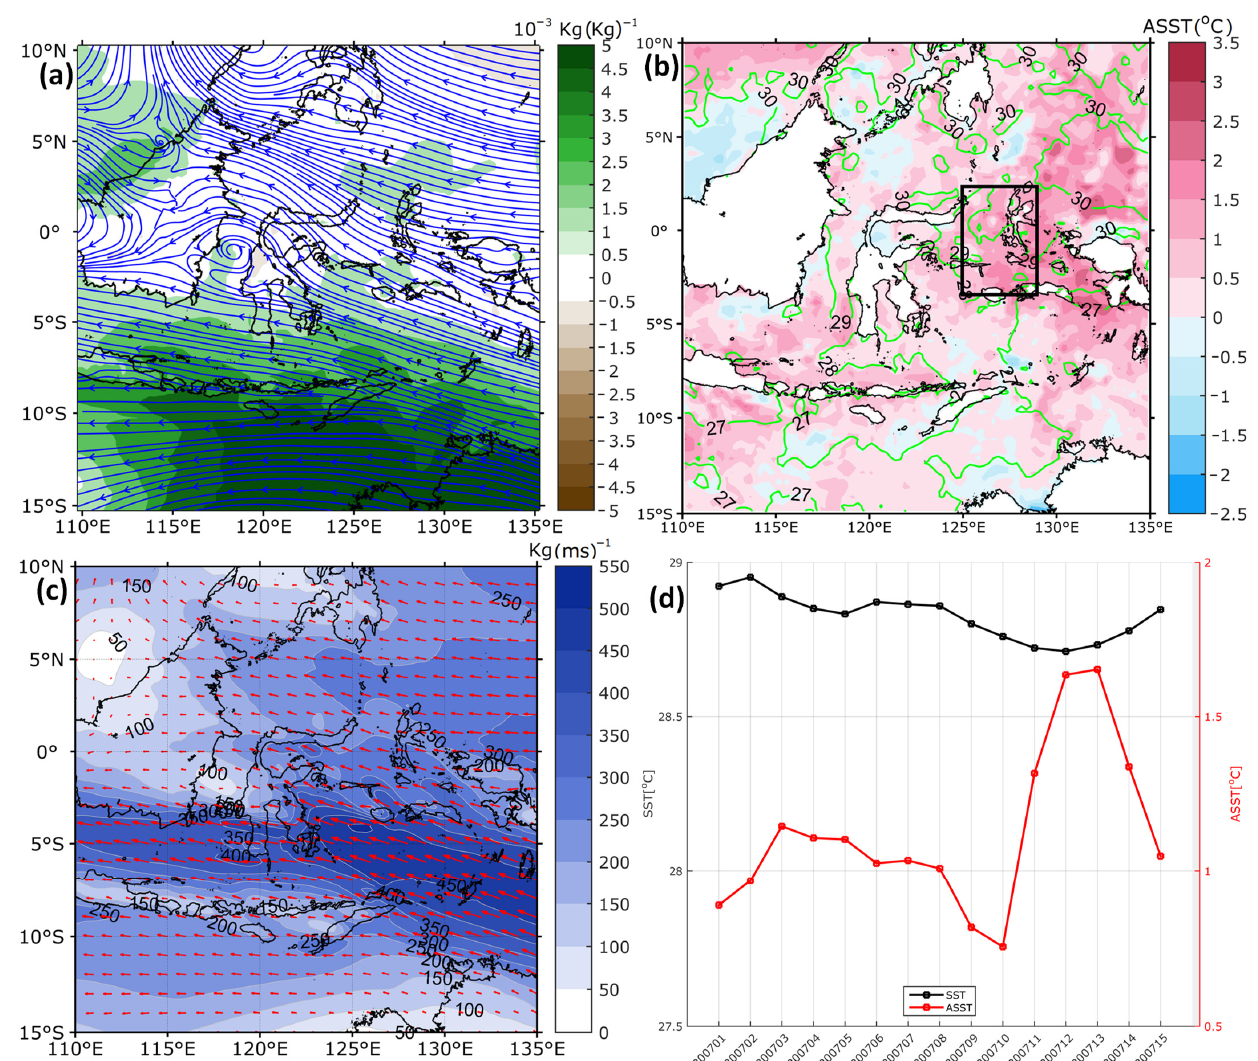
Figure 3. ( a ) Spatial map of specific humidity (shading) and wind at 850 mb (streamlines) averaged from 10 to 15 July 2020 using ERA5 data. ( b ) Same as ( a ), but for SST (contours) and the SST anomaly (shading). ( c ) Same as ( a ), but for the moisture transport integrated from 1000 to 300 mb. ( d ) Time series of daily SST (black) and the SST anomaly (red) averaged over the area shown by the black box in panel ( b ) (3° S–2° N, 125° E–128° E) from 10 to 15 July 2020.